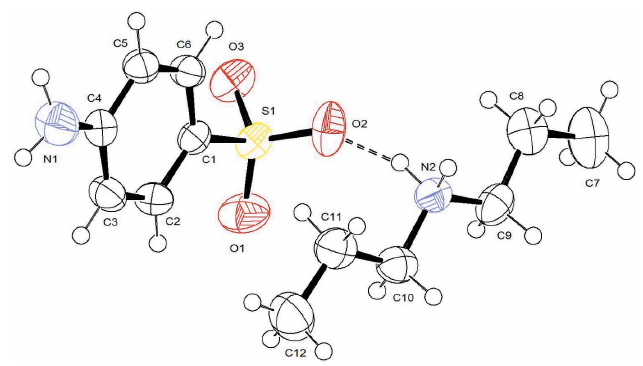
Figure 1 The asymmetric unit with displacement ellipsoids drawn at the 50% probability level. The N2—H2 B (cid:2)(cid:2)(cid:2) O2 hydrogen bond is shown as a dashed line.